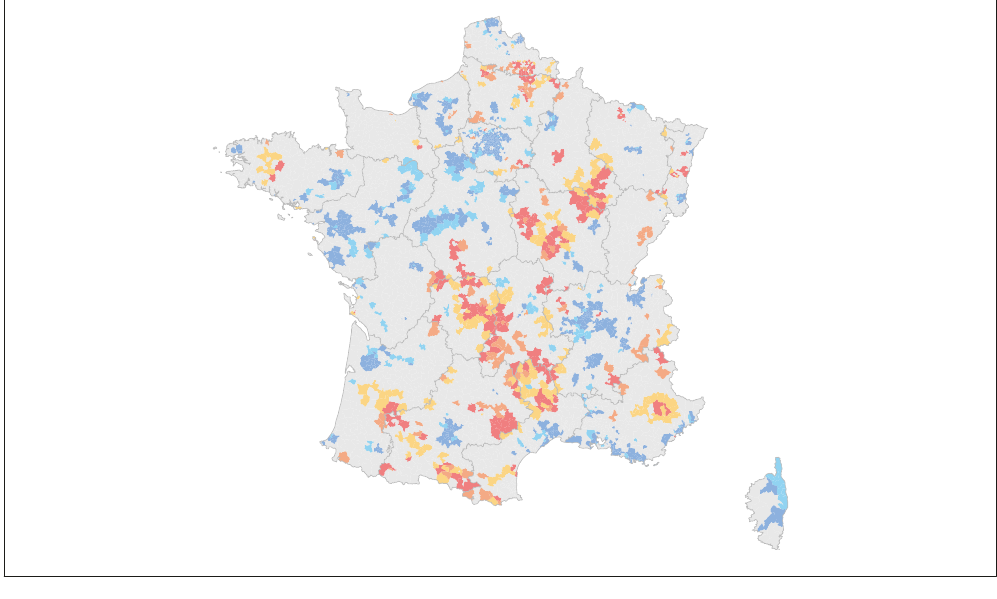
Healthcare and socioeconomic profiles of